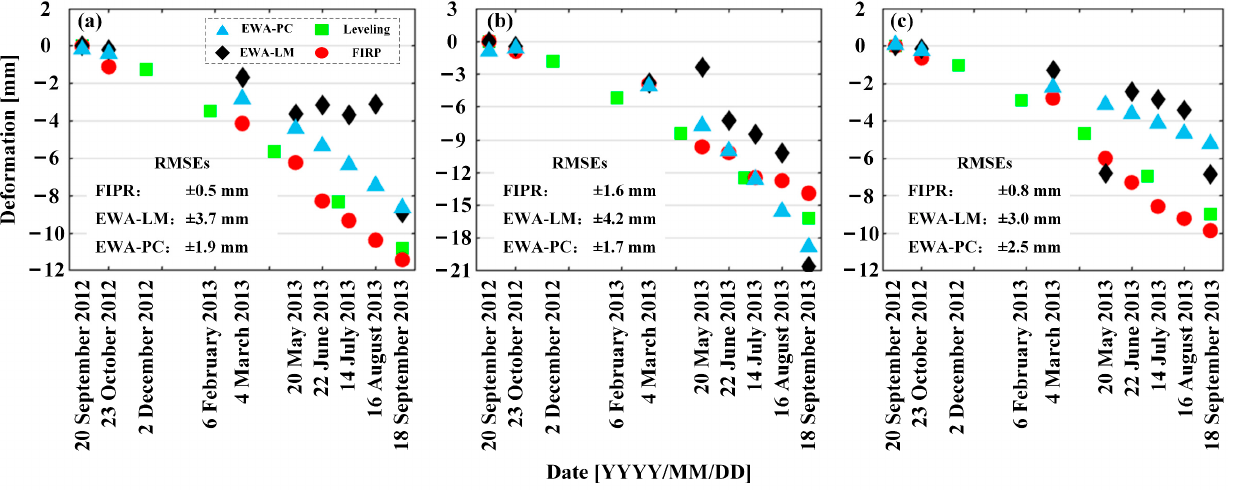
Figure 12. Time-series deformation results compared with leveling measurements on benchmarks. ( a ) G1 in Figure 8. ( b ) G2. ( c )